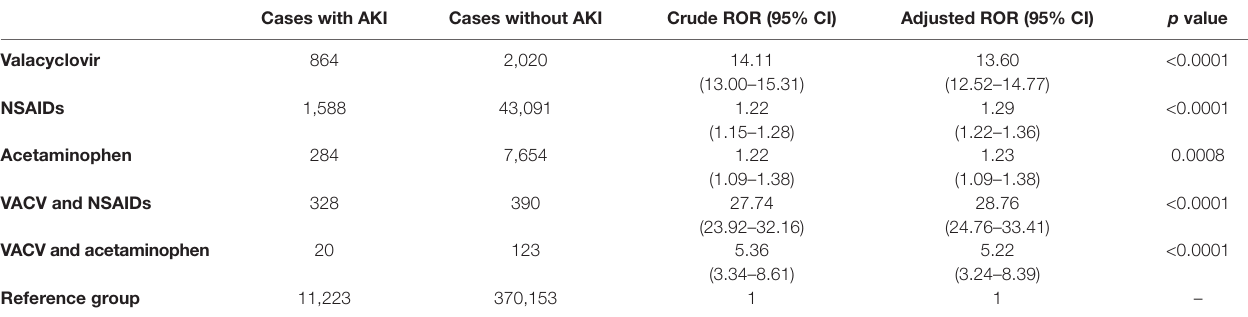
TABLE 2 | Comparison of AKI signals with concomitant use of